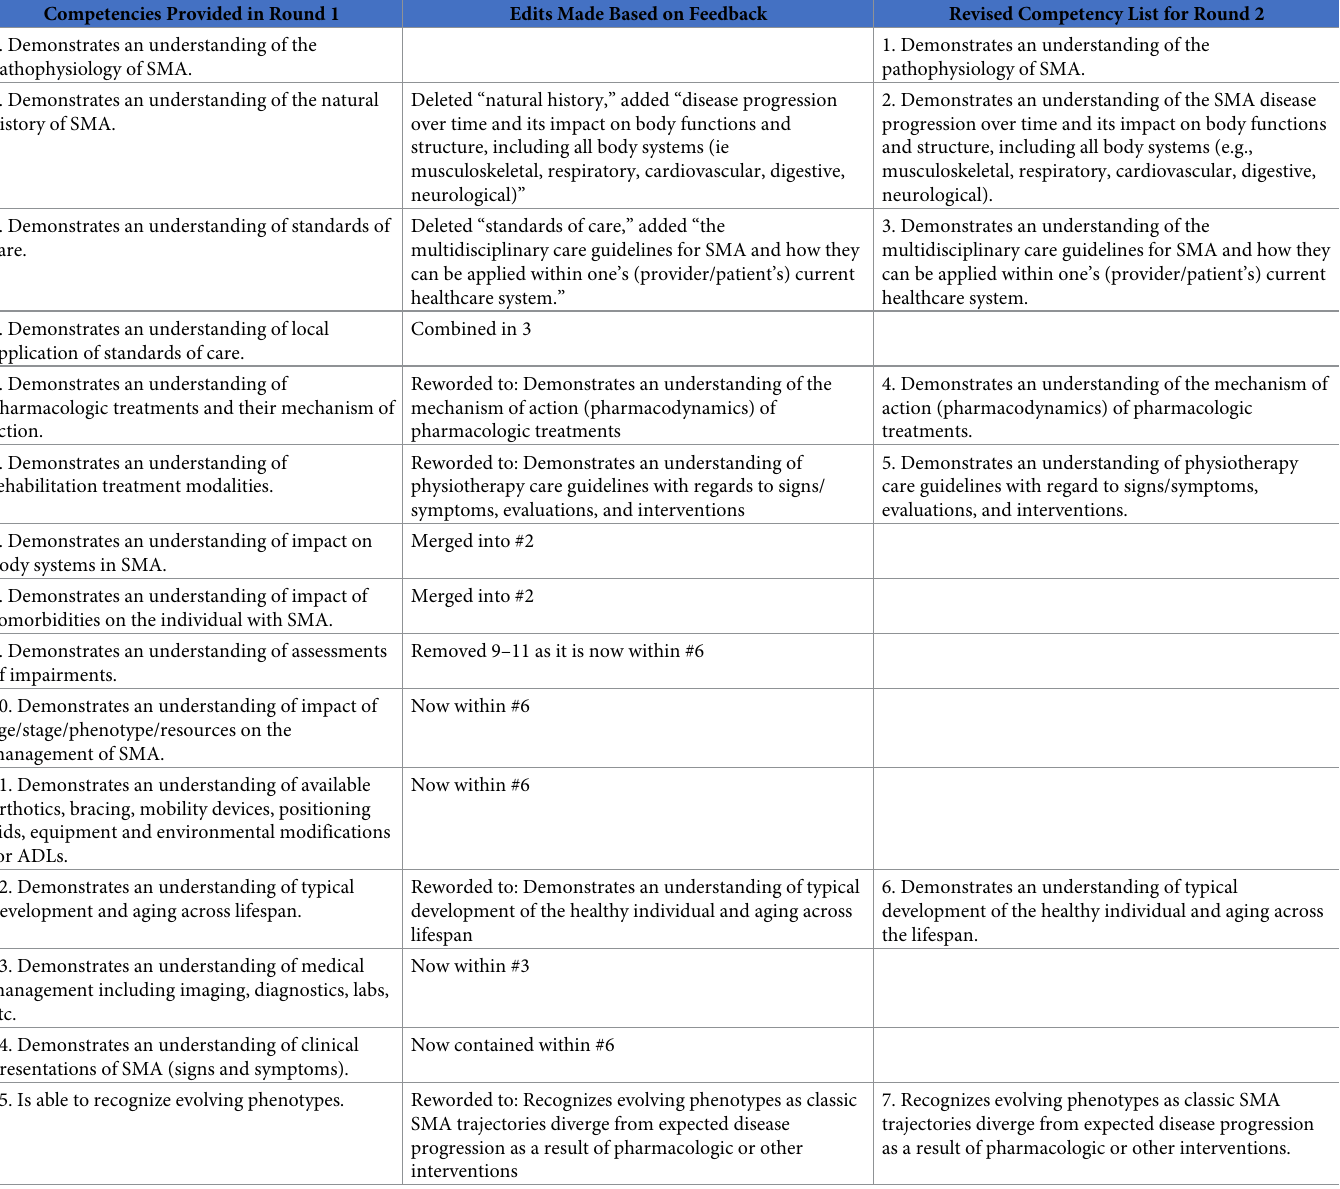
Table 3. Example audit trail of analysis for knowledge of practice